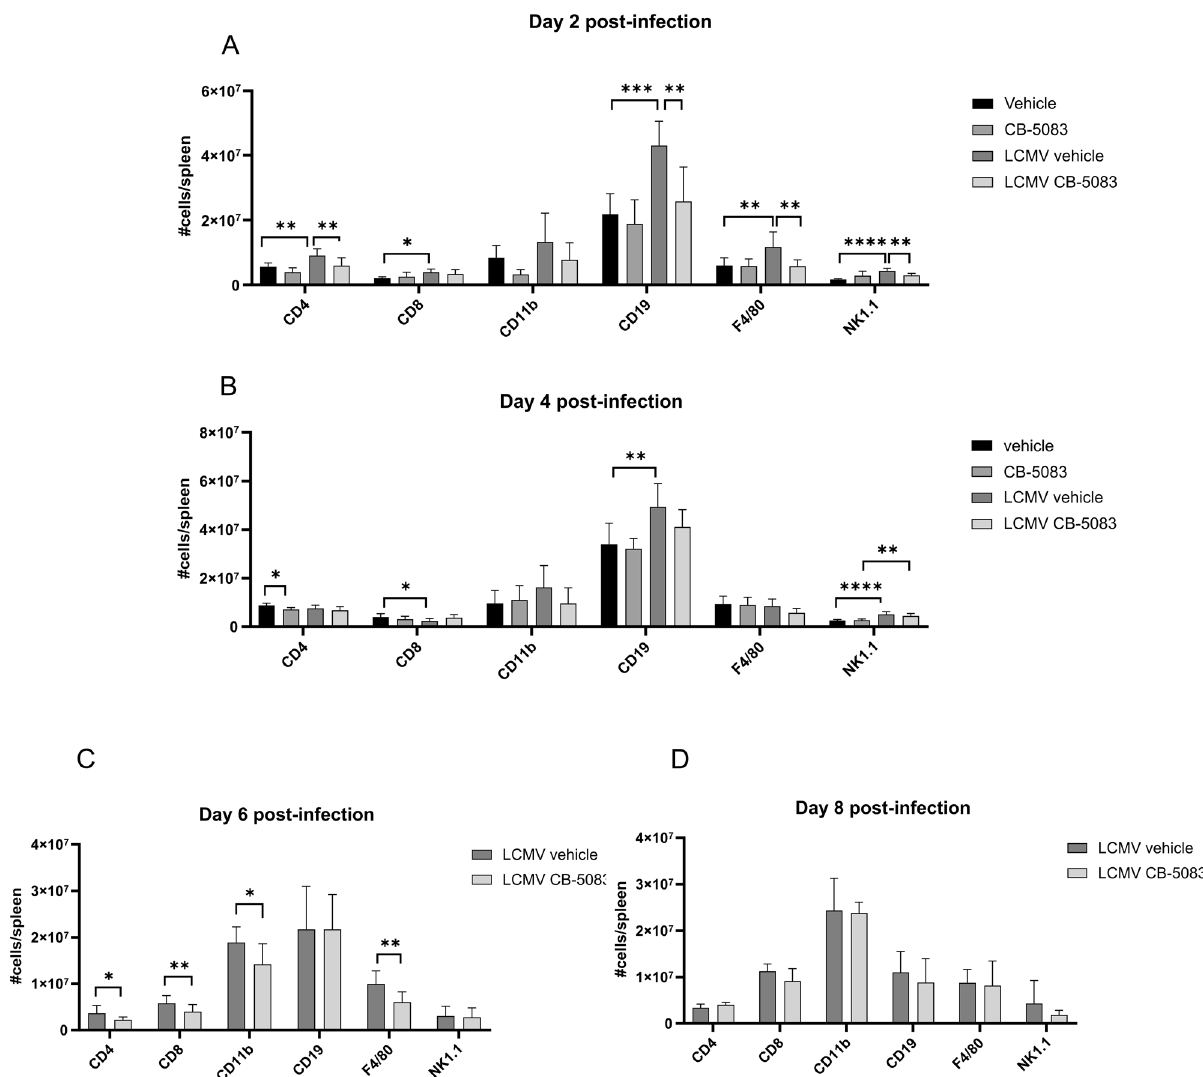
Fig. 4 Analysis of immune cells in the spleen of LCMV-infected CB-5083-treated mice. C57BL/6 mice were infected with LCMV (d0), or left uninfected ( A , B ), and treated with 50 mg/kg CB-5083 or vehicle on d0 and d2 post-infection. Spleens were collected on d2 ( A ), d4 ( B ), d6 ( C ), and d8 ( D ). Splenocytes were stained for CD8, CD4, CD11b, CD19, F4/80, and NK1.1 and analyzed by fl ow cytometry. On the γ -axis, the absolute cell number of each population is shown. Values represent mean ± SD ( n = 5 – 12 per group). A and B were analyzed by individual ordinary one-way ANOVA or Kruskal – Wallis test with multiple corrections performed by Tukey or Dunn ’ s test, respectively. C and D were analyzed by unpaired t test or Mann – Whitney test. For each day analyzed, the data were pooled from two independent experiments. All values represent mean ± SD. * p < 0.05, ** p < 0.01, *** p < 0.001, and **** p < IL-1 β or TNF- α . Flow cytometry analysis of immune cells in the blood (Fig. 6C) and spleen (Fig. 6D) 6 h post-CB-5083 treatment did not reveal alterations in immune cell populations that could explain the observed toxicity of CB-5083. As described above, VCP/p97 inhibition leads to a disturbance of protein home- ostasis in cells within a short time leading to an accumulation of ubiquitylated proteins (Supplementary Fig. 3). Indeed, we detected an accumulation of high-molecular ubiquitin forms in the spleen of CB-5083-treated mice 6 h post-treatment (Fig. 6E). Accumulation of ubiquitin is a hallmark of ER stress leading to induction of the UPR. Phosphorylated eukaryotic initiation factor-2 α (p-eIF2 α ) and BiP (binding immunoglobulin protein aka GRP-78) are two components that initiate the UPR. Both proteins are slightly up-regulated in the spleen 6 h post CB-5083 treatment (Fig. 6E).